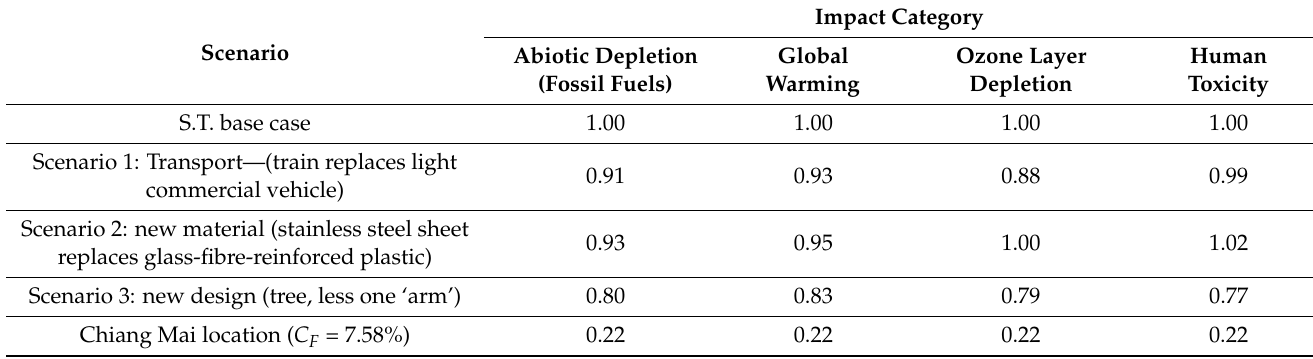
Table 10. LCA results for three Scenarios, 1 to 3 and C F = 7.58% (S.T. base case impacts = 1).